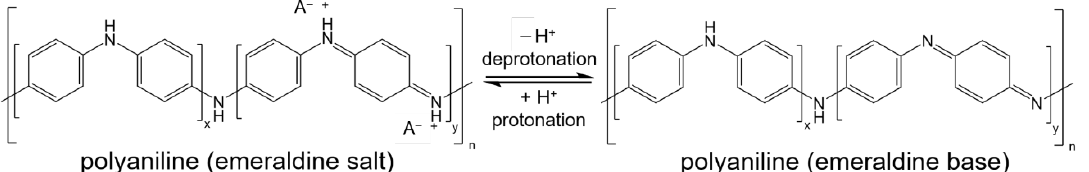
Figure 7. The transformation between the forms of polyaniline emeraldine salt and emeraldine base. A − denotes the counter ion.